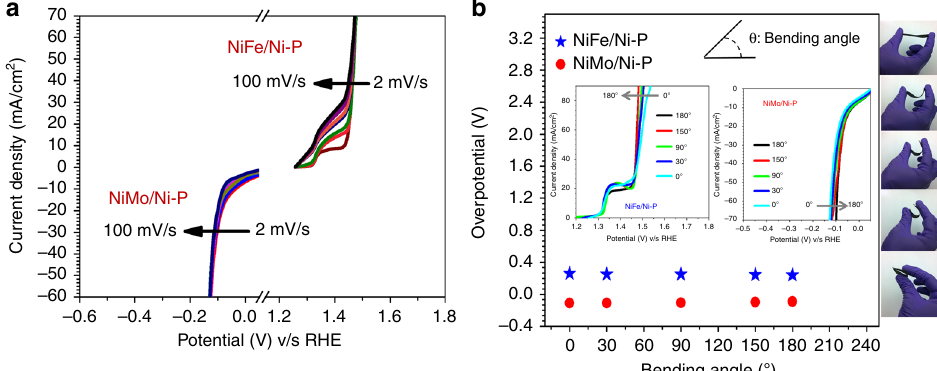
Fig. 8 Scan rate dependence of electrode activity and their performance under bending deformations. a Steady state polarization curves at varying scan rates of 2, 5, 10, 15, 20, 25, 50, 75, and 100mVs − 1 for NiFe/Ni-P and NiMo/Ni-P under OER and HER conditions, respectively. b Flexibility studies of NiFe/ Ni-P and NiMo/Ni-P electrodes showing the overpotentials required to reach current densities of 50 and − 10mAcm − 2 , respectively at different bending angles with corresponding digital images. Insets show full steady state LSVs at different bending angles along with the de fi nition of ‘ bending angle ’ (top) conservation requires equal anodic and cathodic current density, low potential region of 1.2 – 1.4 V (Fig. 9c). For NiFe-NiMo, cat- but with an opposite sign. Therefore, the net cell voltage required alytic current onset is observed at ~1.45 V, however appreciable to achieve a particular current density for total water splitting is gas-bubbles start evolving only at ~1.5 V. A current density of 10 the voltage difference ( Δ V) between the respective half reactions. To verify this, steady state polarization curves were recorded in 1 M KOH and it was found that the Δ V curves plotted by sub- tracting the voltages of individual OER and HER reactions (Fig. 9a) overlap satisfactorily with the iR-corrected LSVs of respective electrolyzers for both NiFe-NiMo and bi-Ni-P couples (Fig. 9b). The steady state LSVs (without iR correction) for both these systems show the Ni(II)/Ni(III) oxidation shoulder in the